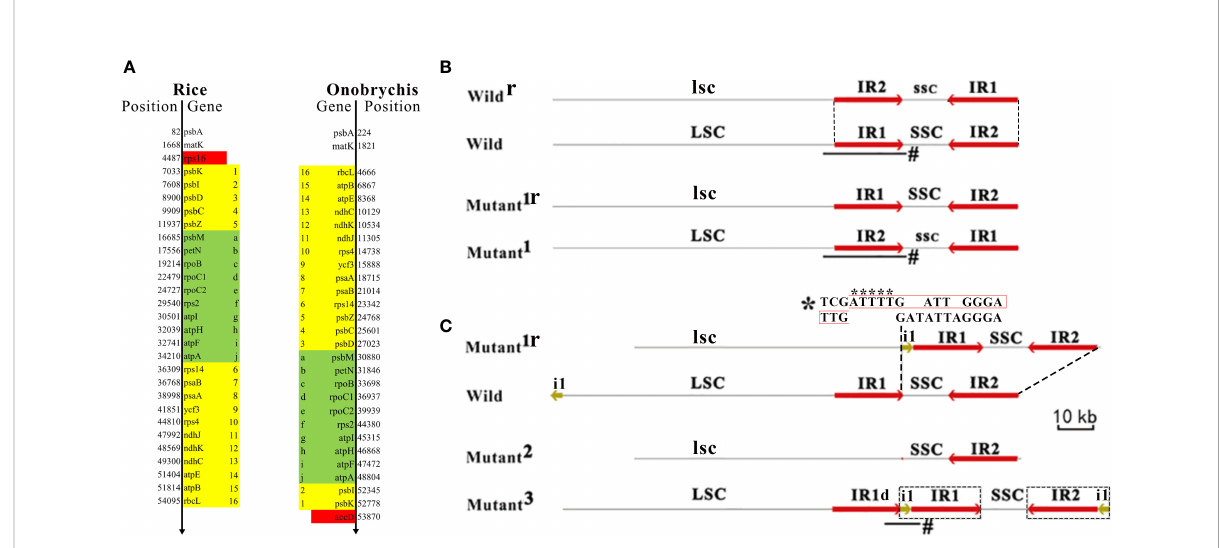
FIGURE 2 Large structural variations in cpDNAs and their formation. Plant chloroplast DNA (cpDNA) typically has a circular structure, including a large single-copy region (LSC), a small single-copy region (SSC) and two inverted repeats (IR1 and IR2). The organization of these four elementary regions LSC-IR1-SSC-IR2 is highly conserved across all plant cpDNAs. (A) A large inversion resulted in a reverse orientation of 26 genes (from psbK to rbcL ) in the LSCs and the loss/acquisition of rps 16 and accD (in red color). Another large inversion resulted in a reverse orientation of 10 genes (in green color). The genomic positions of the genes were annotated according to the Nipponbare cpDNA (RefSeq: NC_001320) and the Onobrychis gaubae cpDNA (GenBank: LC647182). (B) A large inversion of SSC results in a reverse orientation of SSC (denoted as ssc). According to the orientation of SSC, cpDNAs can be classi fi ed into the forward SSC (SSC-F) and reverse SSC (SSC-R) type cpDNAs, which were also designated as wild-type cpDNAs (denoted as wild) and mutants (denoted as mutant 1 ). The frequent inversion of a whole SSC was named as SSC switching. Wild r and mutant 1r represents cpDNAs that have reverse complimentary sequences to wild and mutant 1 , respectively. LSC and SSC are reverse complimentary to lsc and ssc, respectively. As IR1 is identical to IR2, both LSC-IR1-ssc-IR2 and LSC-IR2-ssc-IR1 represent the same sequence (C) The recombination between mutant 1r and wild resulted in a cpDNA (mutant 2 ) that lost a IR and another (mutant 3 ) that acquired a IR. Although the IR − lacking cpDNA (mutant 2 ) was not detected in the present study, it had been previously reported in Onobrychis spp (Moghaddam et al., 2022). While the 319-bp deleted segment was at the 3 ’ end of the IR1 the 22810-bp insert includes fi ve nucleotides “ ATTTT ” plus a 2000-bp segment of LSC (denoted as i1) and a whole IR1. The 319-bp lacking IR1 is denoted as IR1d. A high-score segment pair (HSP) that may be involved as recombination sites (indicated by *) was detected between the 5 ’ end of the 319-bp deleted segment (the below sequence) and that of i1 (the above sequence). Junction reads (indicated by #) were used to validate these structural variations (Materials and methods). The sequence (in black box) synthesized during recombination contain an insert of fi ve nucleotides “ ATTTT ” (indicated by asterisks below) that resulted in a repeat